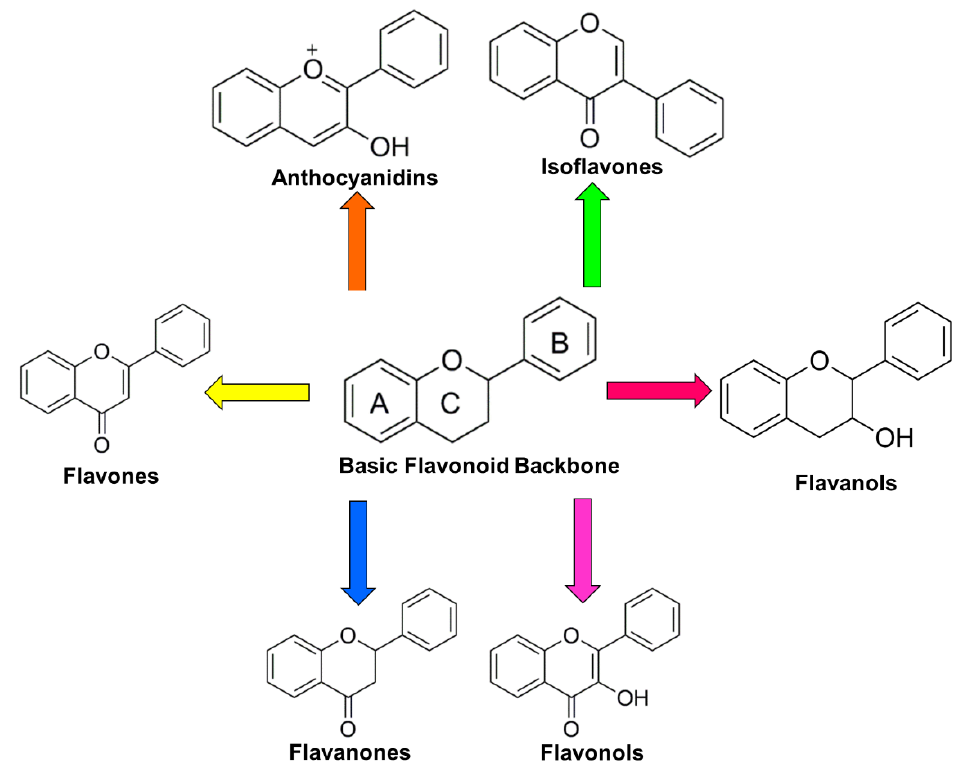
Figure 1. Basic structure of flavonoids and their subclasses. The core structure of flavonoids is a diphenylpropane skeleton (C6-C3-C6), which contains two phenyl rings and one heterocyclic ring. Based on their chemical structure, flavonoids can be further classified further into flavones, flavanones, flavanols, flavonols, isoflavones, and